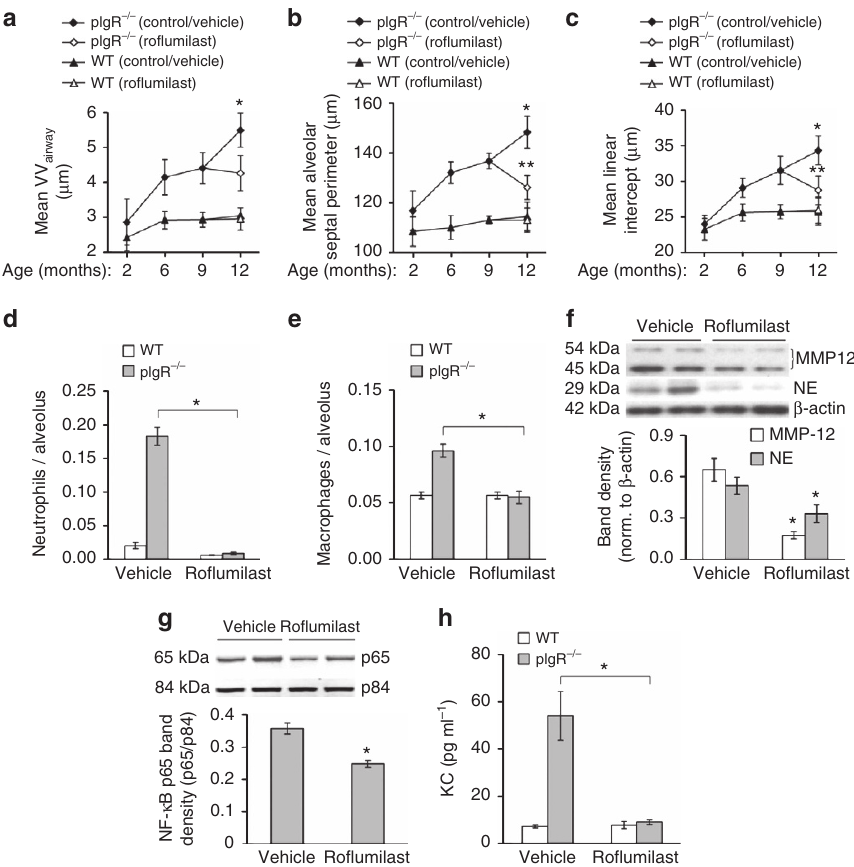
Figure 6 | Roflumilast blocks inflammation and COPD-like lung remodelling in pIgR (cid:2) / (cid:2) mice. ( a – c ) Morphometric analysis showing small airway wall thickness (VV airway ), mean alveolar septal perimeter length and mean linear intercept at the indicated ages in pIgR (cid:2) / (cid:2) and WT mice treated with roflumilast or vehicle from 9 to 12 months of age. Five to ten mice per group; * P o 0.01 compared with 12-month-old pIgR (cid:2) / (cid:2) mice treated with roflumilast, ** P o 0.05 compared with 6- and 9-month-old pIgR (cid:2) / (cid:2) mice (two-way analysis of variance (ANOVA)). ( d , e ) Parenchymal neutrophil and macrophage counts in 12-month-old WT and pIgR (cid:2) / (cid:2) mice treated for 3 months with roflumilast or vehicle. Six to seven mice per group; * P o 0.01 (macrophages) or P o 0.001 (neutrophils) compared with pIgR (cid:2) / (cid:2) mice treated with vehicle (Student’s t -test). ( f ) Western blotting and densitometry for MMP-12 and NE in lung tissue from 12-month-old pIgR (cid:2) / (cid:2) mice treated with roflumilast or vehicle. Band densities of MMP-12 and NE were normalized to b -actin. Six mice per group; * P o 0.05 (Student’s t -test). ( g ) Western blotting and densitometry for p65 component of NF- k B (normalized to p84) in lung nuclear protein extracts from 12-month-old pIgR (cid:2) / (cid:2) mice treated with roflumilast or vehicle. Six mice per group; * P o 0.01 (Student’s t -test). ( h ) KC protein levels in BAL fluid from 12-month-old WT or pIgR (cid:2) / (cid:2) mice treated with roflumilast or vehicle. Six mice per group; * P o 0.05 compared with pIgR (cid:2) / (cid:2) mice treated with vehicle (Student’s t